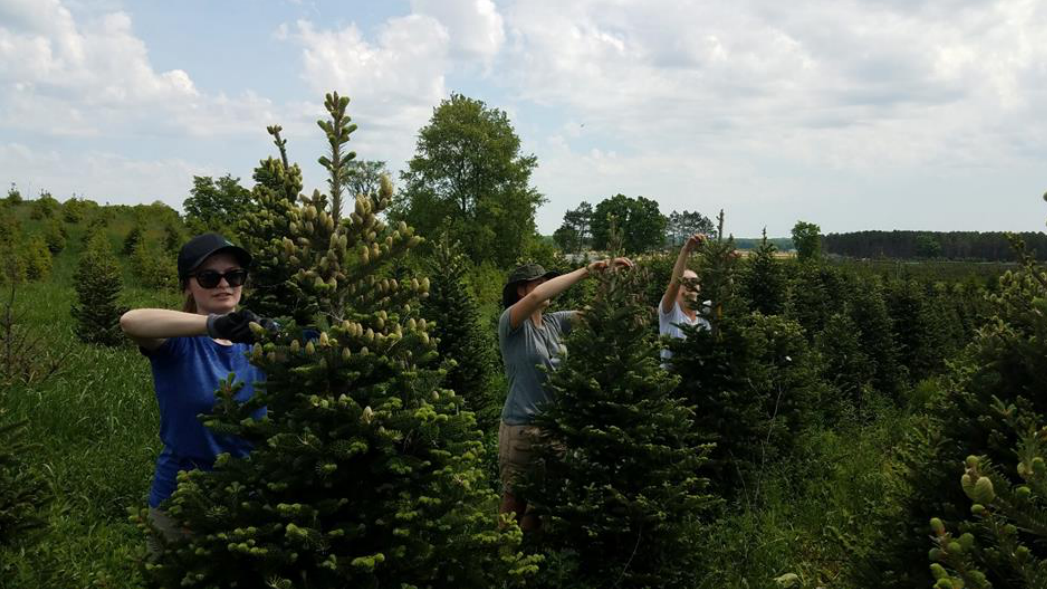
Figure 3. Research assistants assess coning on Fraser fir Christmas trees.